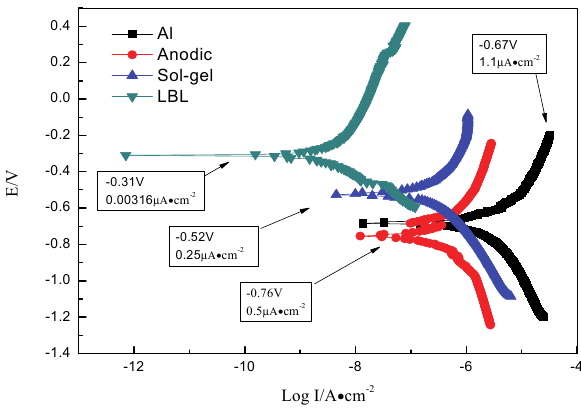
Figure 8. Polarization curves of Al alloy, anodic oxide film, sol–gel film, and LBL film.